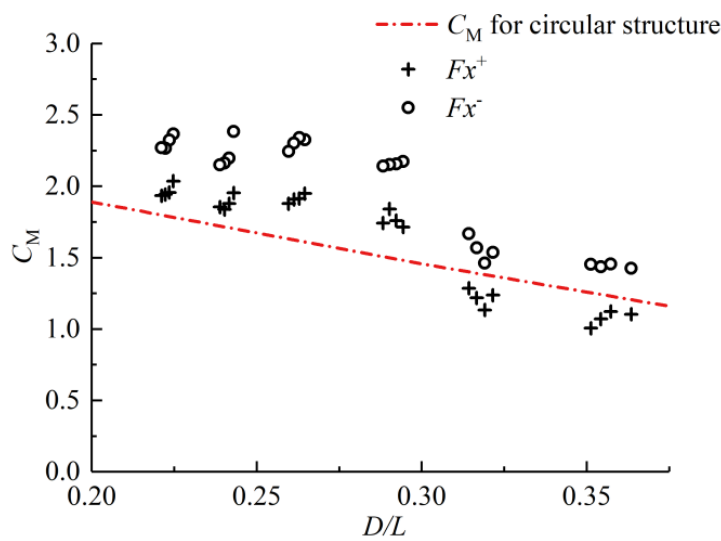
Figure 7. Comparison of the measured and predicted peak forces.